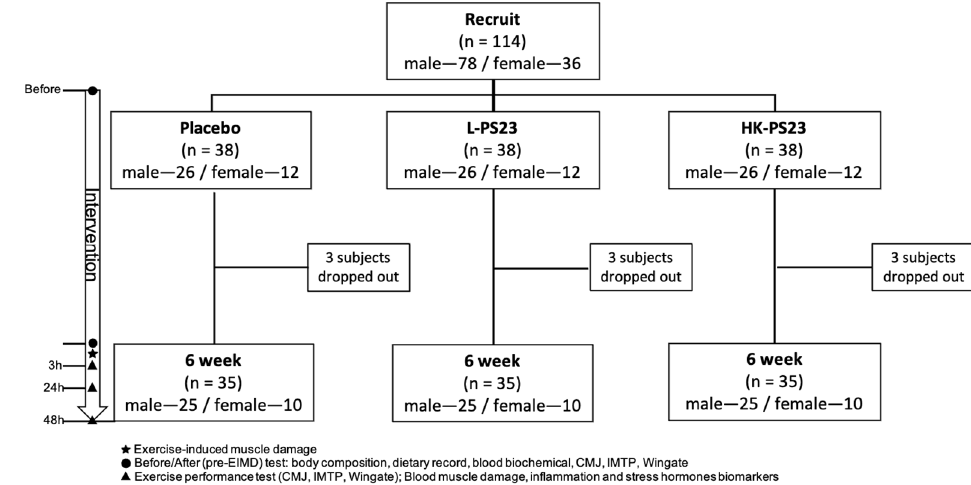
Figure 1. Experimental procedure